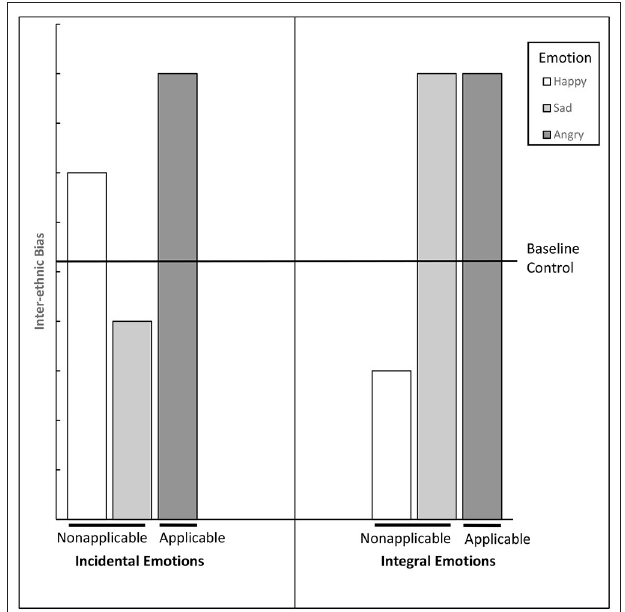
FIGURE 1 | Pattern of predicted effects of emotions on interethnic bias as a function of emotion source (incidental = extrinsic to the outgroup partner; integral = intrinsic to the outgroup partner), and emotion applicability (applicable = relevant to the outgroup; non-applicable = irrelevant to the outgroup), as extrapolated from three independent lines of past emotion research. The inferred pattern suggests the existence of two broad emotion effects on bias: (1) opposite effects for incidental/integral-non-applicable emotions (cf. incidental/integral happy bars vs. baseline and incidental/integral sad bars vs. baseline; Prediction 1 ); (2) similar effects for incidental/integral-applicable emotions (cf. incidental/integral angry bars vs. integral happy/baseline; Prediction 2